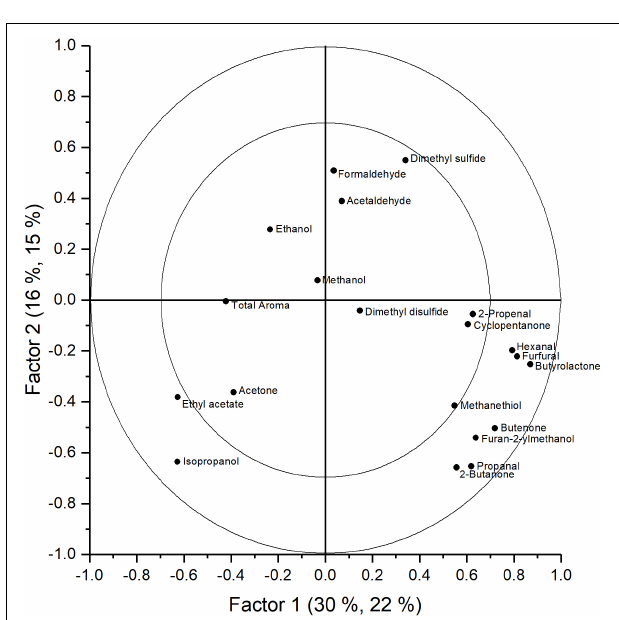
FIGURE 6 | Loadings plot obtained with the PLS analysis of the aroma measurement of the headspace in the storage containers analyzed with TD-GC-MS.